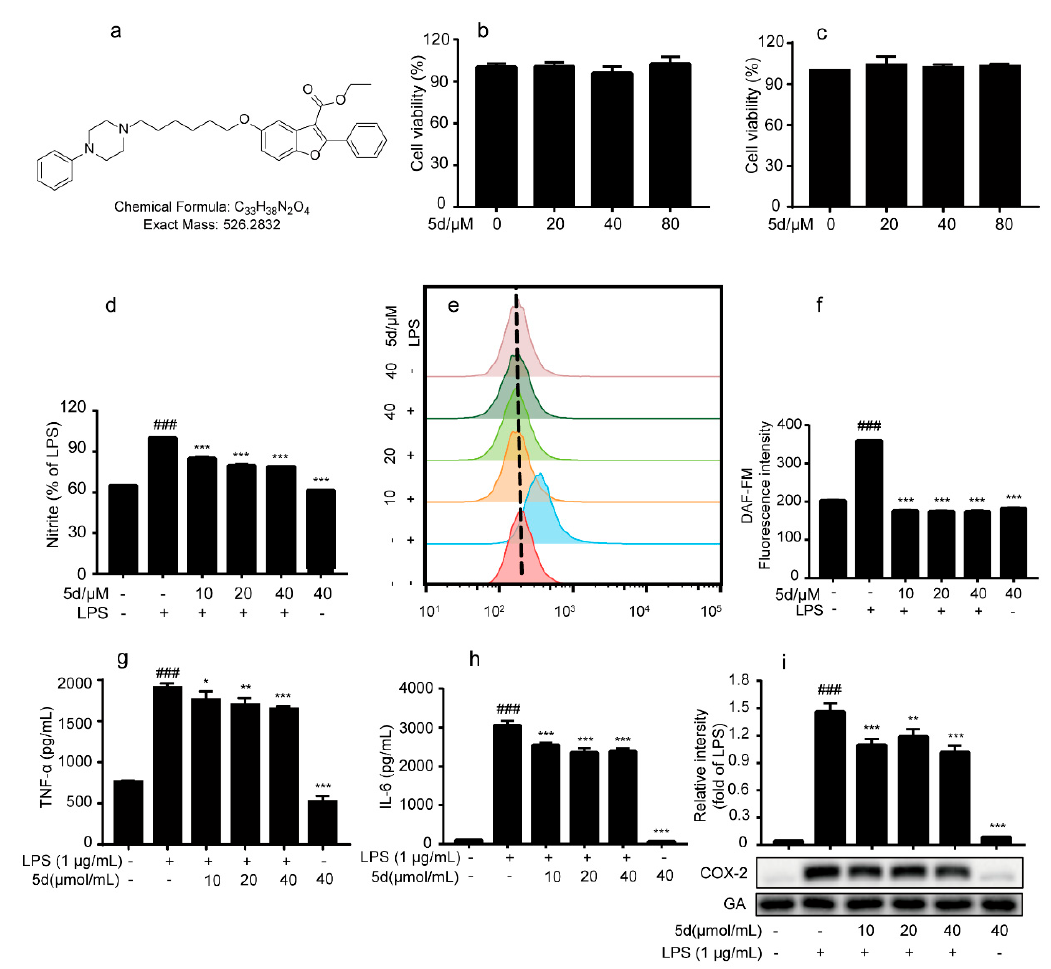
Figure 7. Effects of compound 5d on pro - inflammatory factors in LPS-induced RAW264.7 cells. ( a )